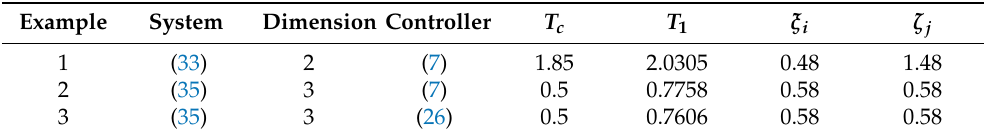
Table 1. Comparison of